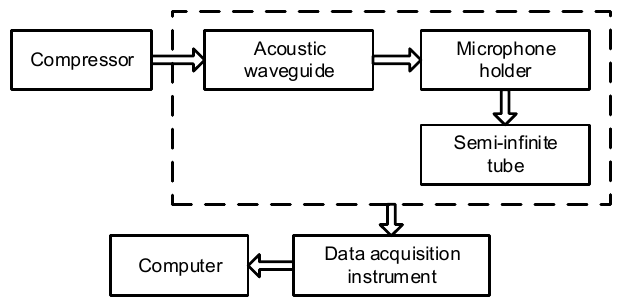
Figure 1. Schematic diagram of measurement system.